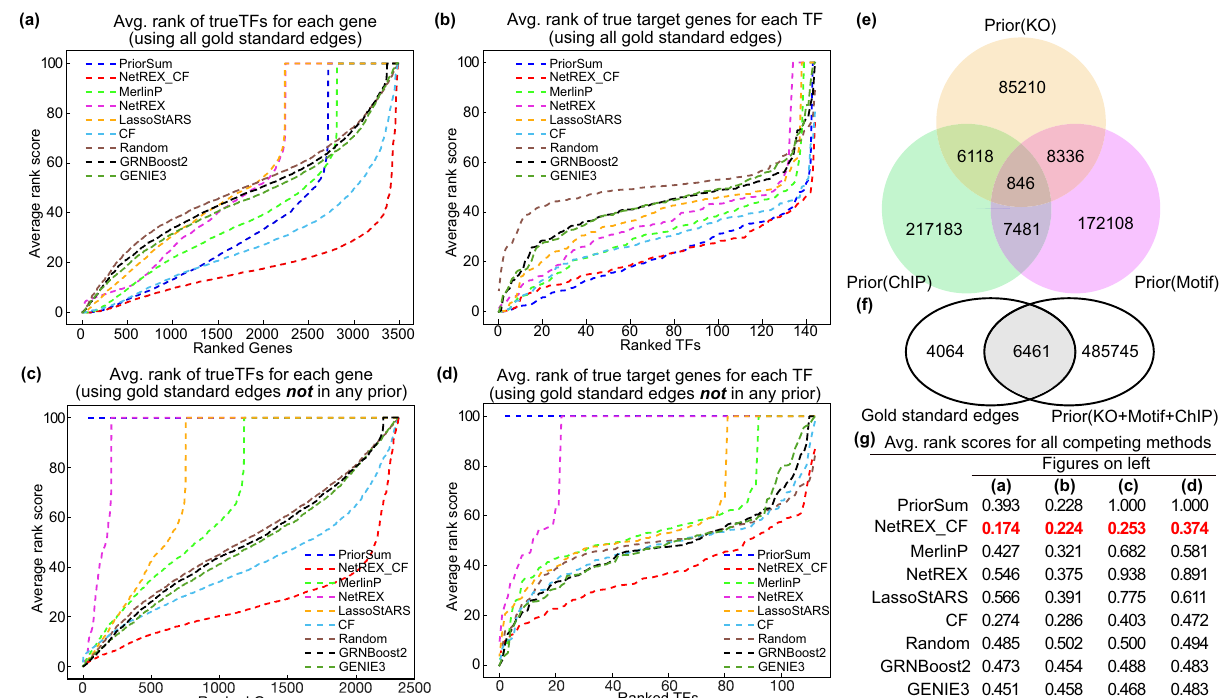
Fig. 2 Performance comparison for all competing algorithms on the yeast dataset. a The performance of the methods on the task of predicting regulating TFs: for each algorithm, we compute for each gene the rankings of gold standard edges rank g adjacent to it, sort them in descending order, and plot the i sorted average rankings. b The performance of the methods on the task of predicting regulated genes using a measure similar to in ( a ) but focusing on genes regulated by TFs. c The performance of the methods on the task of predicting regulating TFs that are not observed in prior data. The procedure is the same as in ( a ) but only the gold standard edges that are not included in the prior knowledge are used for the evaluation. d The performance of the methods on the task of predicting regulated genes not observed in prior data (similar to ( c ) but focusing on genes regulated by TFs). e Overlap between priors. f Venn diagram for gold standard dataset and the union of the three prior datasets. g Summary of the average rankings of each algorithm for tasks reported in panels ( a – d ). The lowest scores are highlighted in bold